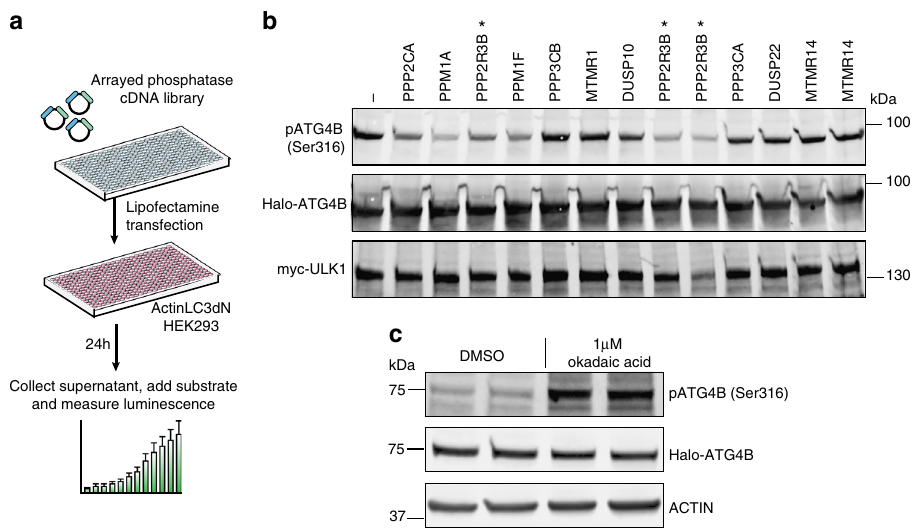
Fig. 5 A phosphatase screen identi fi es PP2A as an endogenous regulator of ATG4B Ser316 dephosphorylation. a Schematic work fl ow of the cDNA phosphatase screen. b HEK293T cells after 24 h co-transfection with selected phosphatases and myc-ULK1 and Halo-ATG4B were analysed for the phosphorylation status of ATG4B on Ser316. The samples overexpressing the PP2A regulatory subunit 3B (PPP2R3B) are marked with an asterisk . Please note that the three different cDNA clones were transfected for PPP2R3B, all of which showed a reduction in phosphor-Ser316 compared with the control sample. Representative immunoblots are shown. c Cell lysates from HeLa cells stably expressing Halo-ATG4B WT and treated for 30 min with 1 µ M okadaic acid or DMSO were probed for phosphorylation of ATG4B on Ser316 and then re-probed for Halo and β -actin expression.